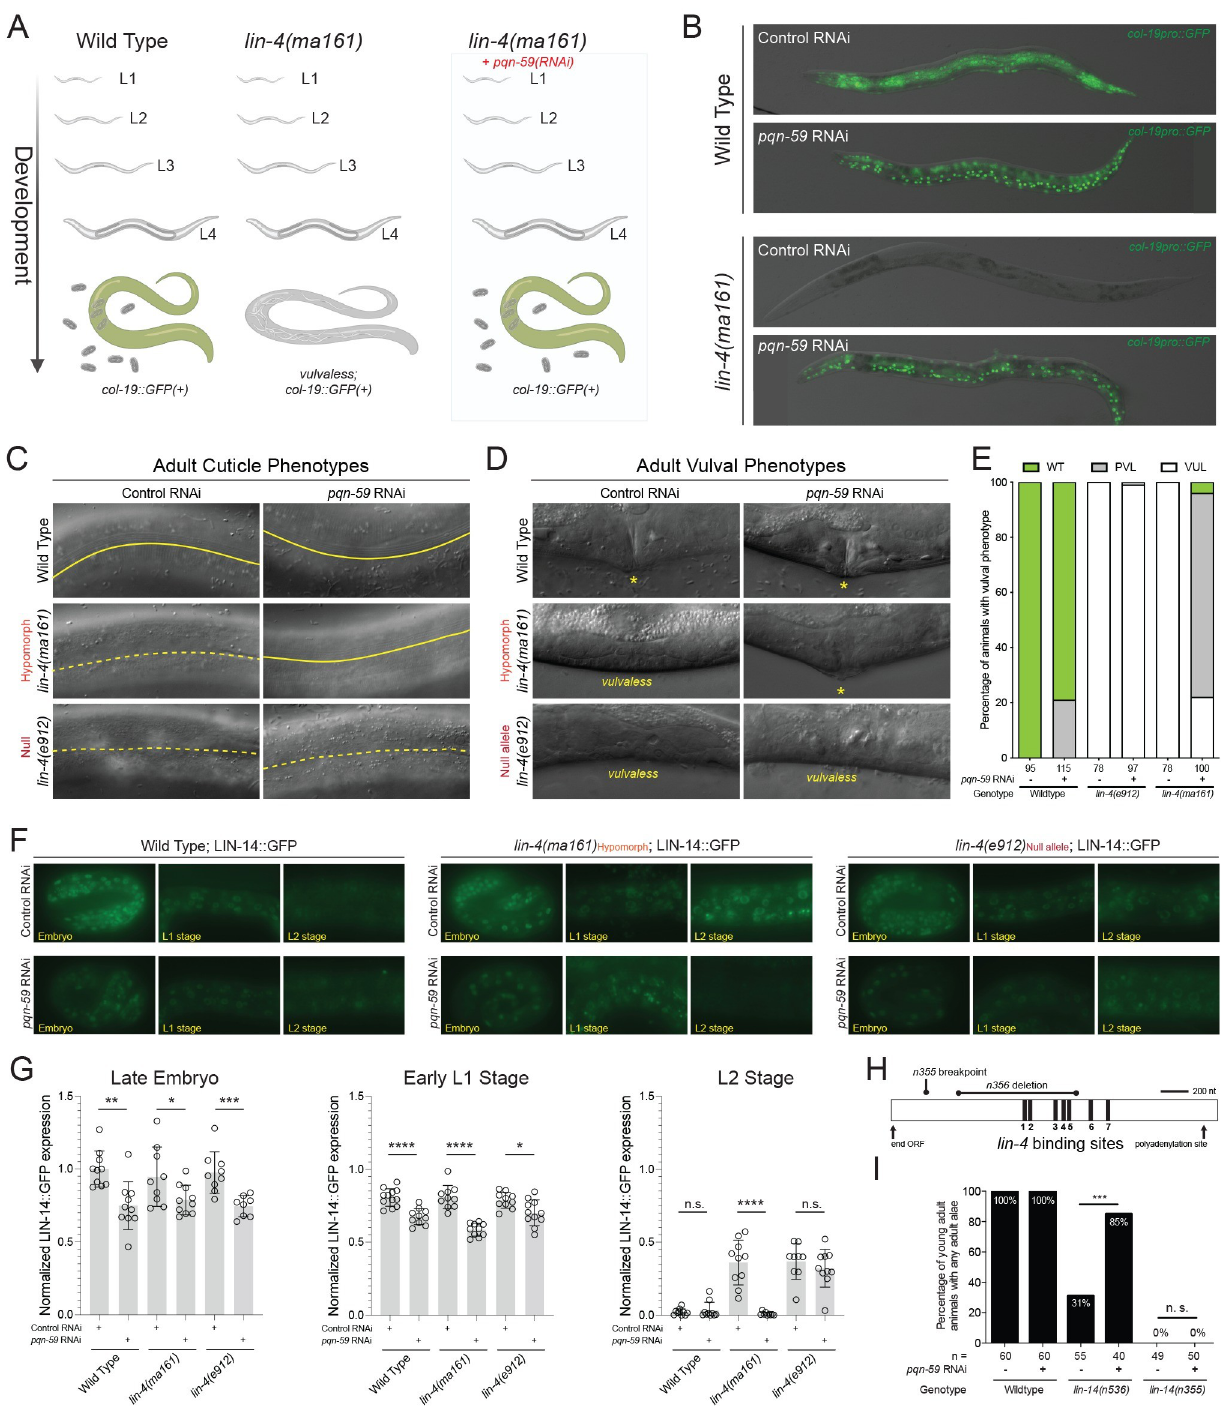
Fig 1. pqn-59(RNAi) suppresses reiterative heterochronic phenotypes associated with reduced lin-4 -mediated repression of lin-14 . (A) Genetic screen used to identify suppressors of lin-4(ma161) heterochronic phenotypes. Wild-type animals express the adult-specific col-19 :: GFP transcriptional reporter at the end of the L4 molt and throughout adulthood. In contrast, lin-4(ma161) animals fail to express col-19 :: GFP and are unable to lay eggs due to the inappropriate reiteration of L1-specific developmental programs. Depletion of pqn-59 by RNAi suppresses both lin-4(ma161) phenotypes. (B) Pictographs of adult wild-type and lin-4(ma161) animals exposed to control or pqn-59 dsRNAs. See Table 1 for details. (C and D) Pictographs depicting the comparison of adult-specific alae and vulval structures of wild-type, lin-4(ma161) , and lin-4(e912) animals exposed to control or pqn-59 dsRNAs. In panel C, solid line indicates continuous adult alae while a dashed line depicts the regions of the cuticle that lack these cuticular structures. In panel D, asterisks